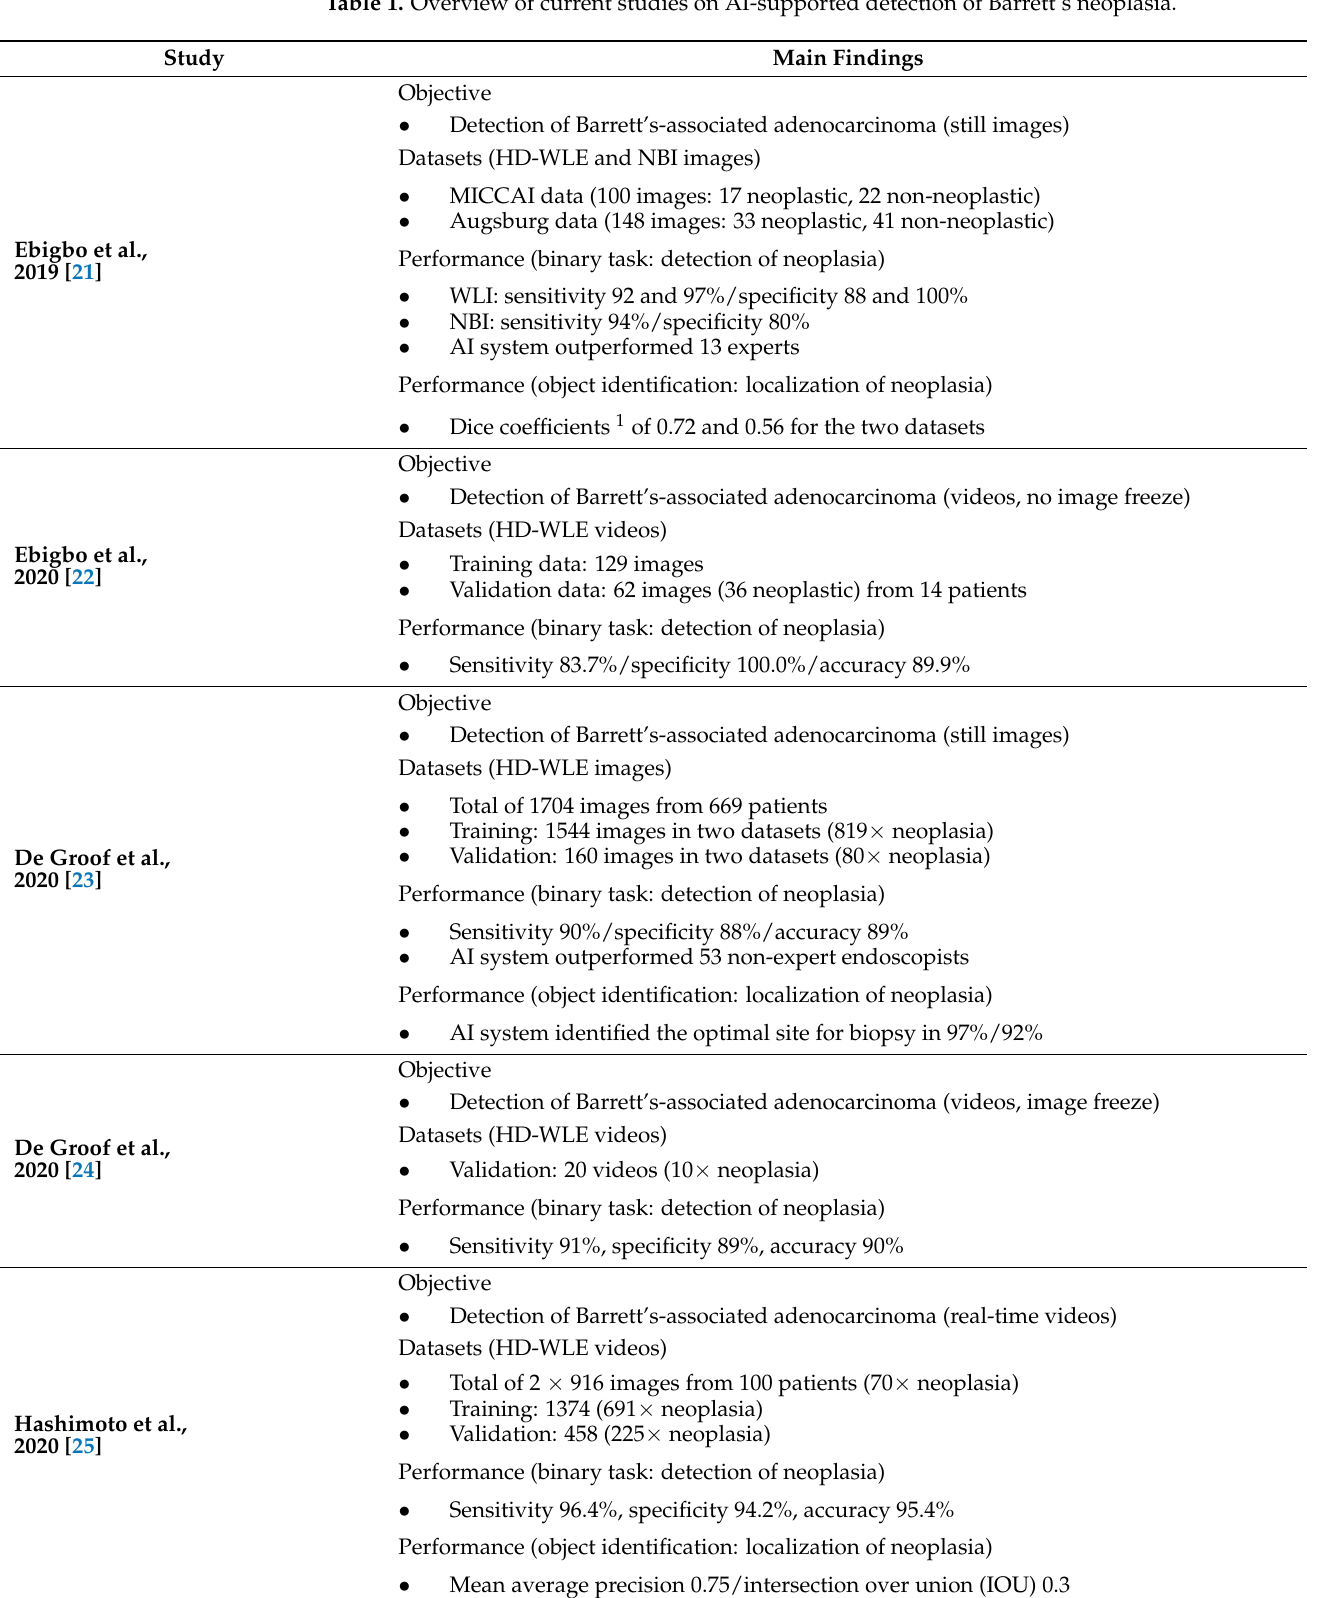
Table 1. Overview of current studies on AI-supported detection of Barrett’s